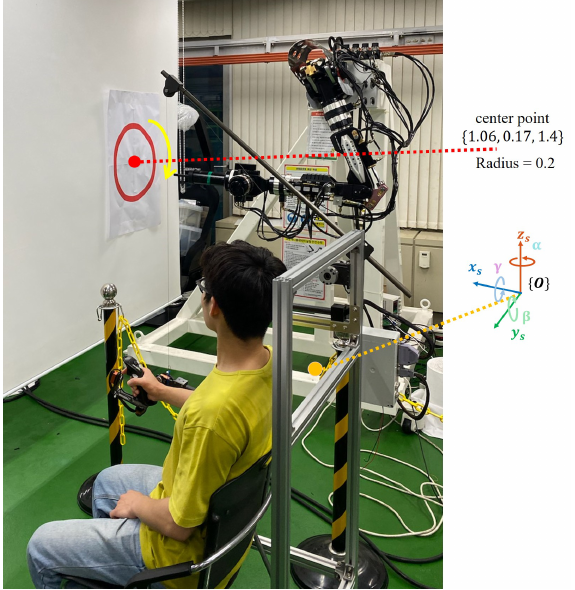
Figure 12. Teleoperation task performance